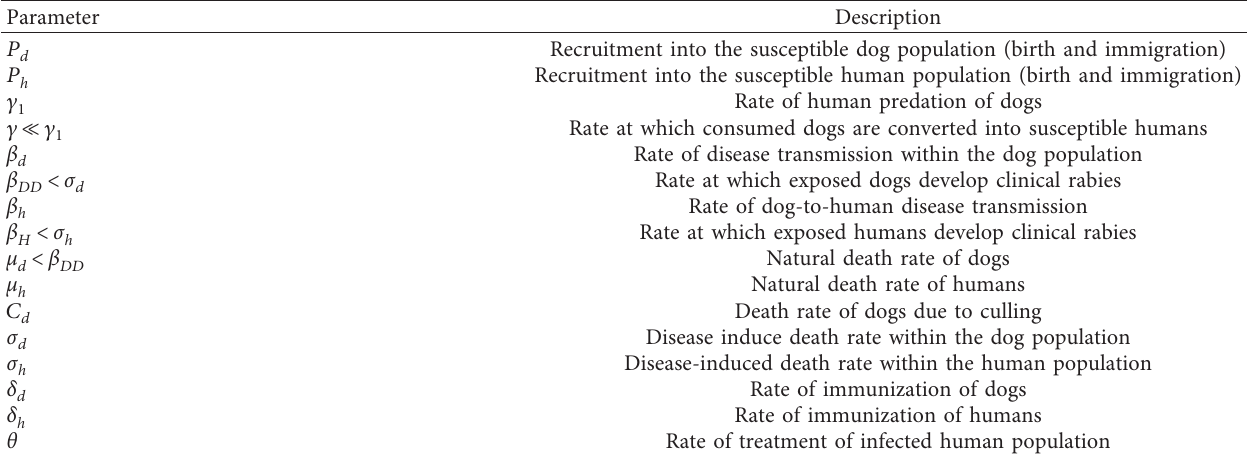
Table 1: Description of parameters of the